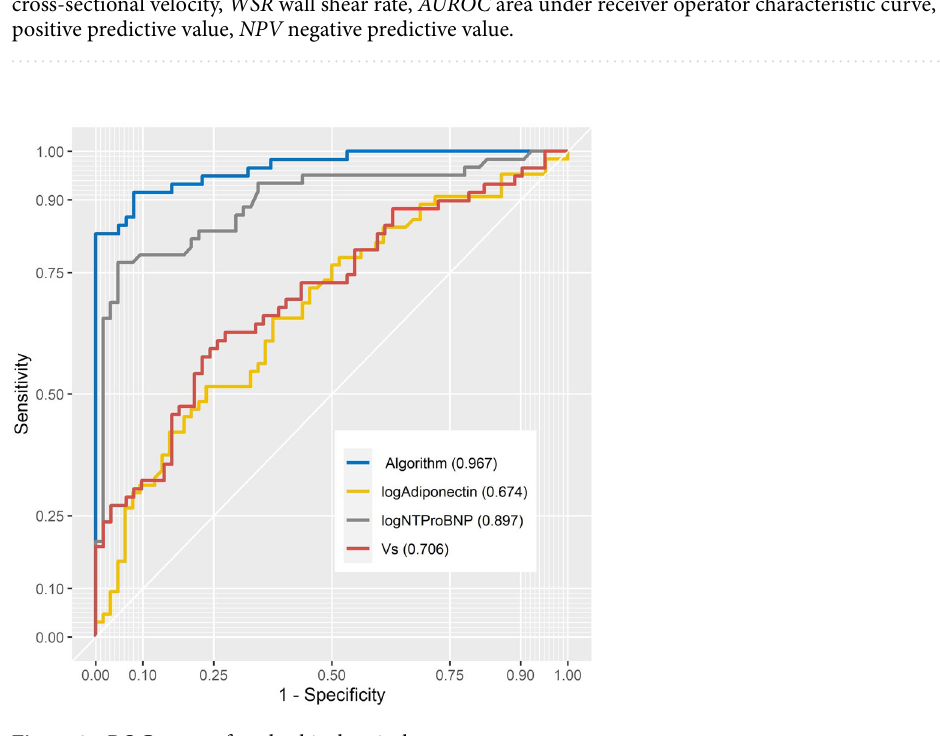
Figure 2. ROC curve of ocular-biochemical